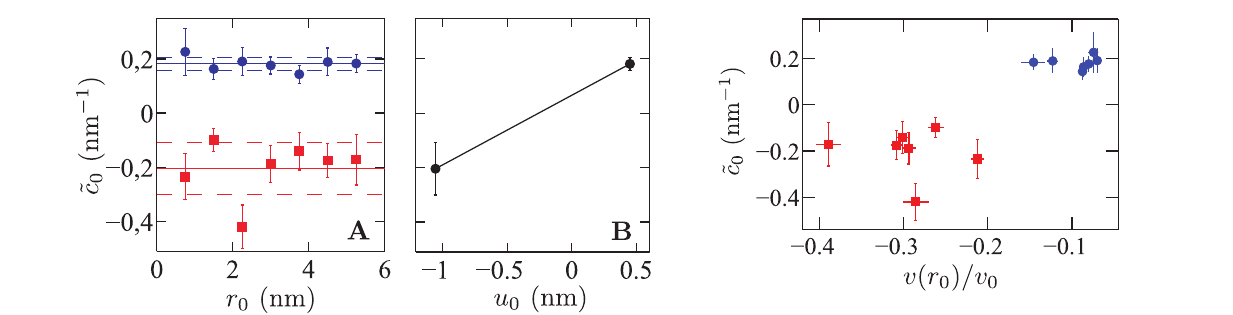
Figure 5. Renormalized spontaneous curvature ~ cc 0 as a function of the inclusion radius r 0 and the hydrophobic mismatch u 0 . A ) ~ cc 0 versus r 0 . The values of ~ cc 0 were obtained by fitting each thickness deformation profile of Ref. [15]. Circles (blue): positive mismatch, u 0 ~ 0 : 45nm . Squares (red): negative mismatch, u 0 ~{ 1 : 1nm . Solid lines: average values; dotted lines: standard deviation over the seven data points (corresponding to the different r 0 ), for each value of u 0 . B ) Average value of ~ cc 0 (see A) as a function of the hydrophobic mismatch u 0 . The equation of the line joining the two data points has a slope 0 : 26nm { 2 .